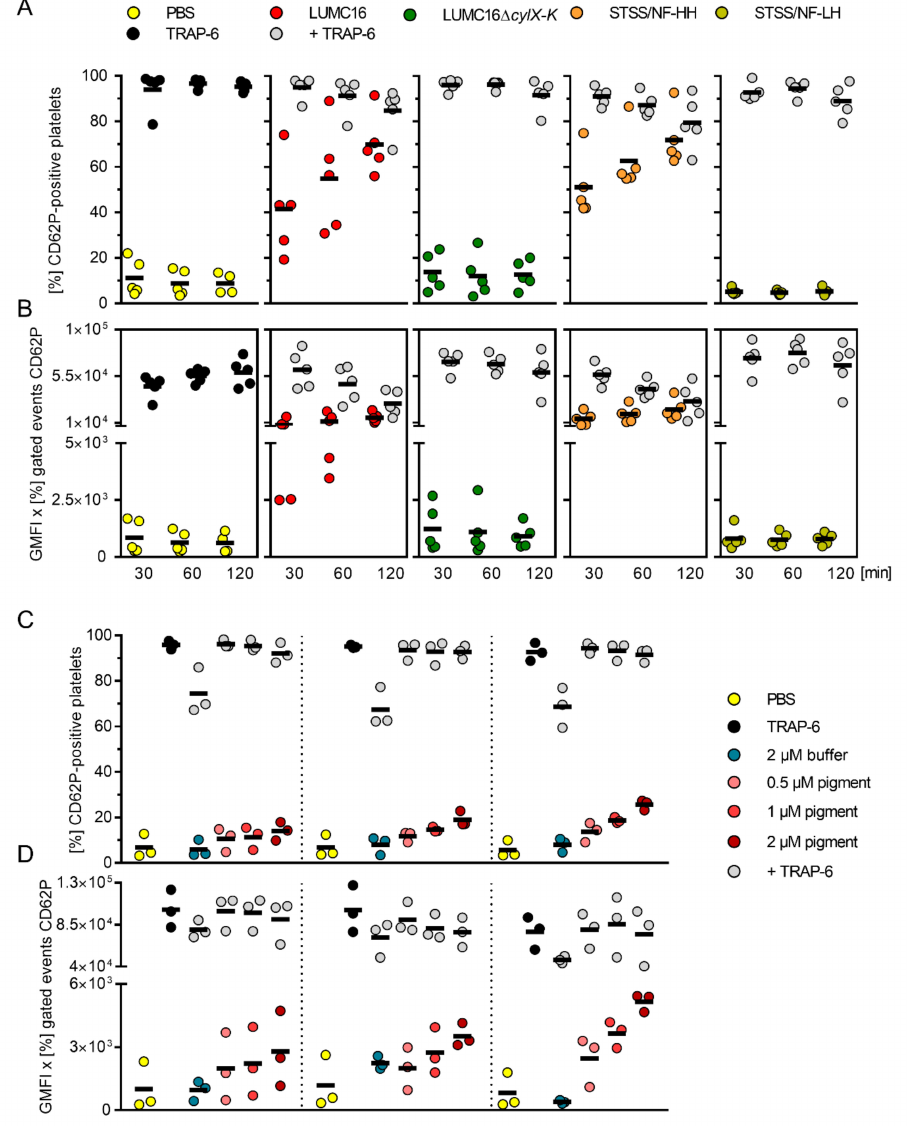
Figure 2. GBS pigment initially activates human platelets. Washed human platelets were infected with pigmented (LUMC16 and STSS/NF-HH) and non-pigmented (LUMC16 ∆ cylX-K or STSS/NF- LH) GBS strains at MOI 0.1 or were incubated with increasing concentrations of the pigment. Platelet activation was measured via flow cytometry using a PE-Cy5 labelled CD62P antibody. TRAP- 6 (40 µ M) and PBS were used as positive and negative controls, respectively. Alternatively, 5 min prior to the end of infection or pigment stimulation, TRAP-6 was added. The activation process was evaluated by assessing frequencies of CD62P-positive cells ( A , C ) as well as expression of CD62P ( B , D ). Each dot represents one independent experiment with cells from one donor (A and B, n = 5; C and D, n = 3). Horizontal lines depict mean values. Abbreviations (GMFI, geometric mean of fluorescence